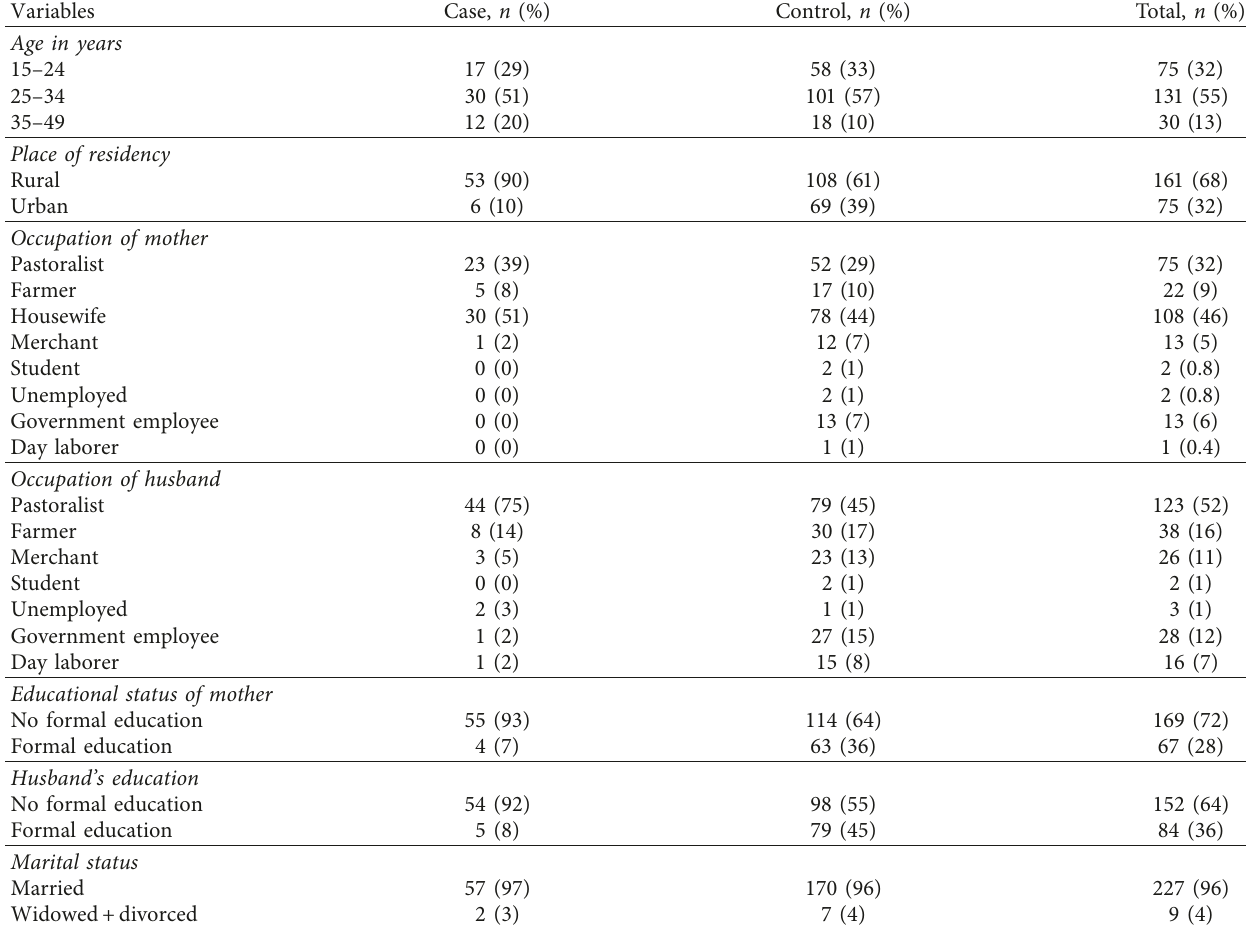
Table 2: Sociodemographic characteristics of pregnant women who delivered between September 2014 and March 2017 at pastoralist area of Borena zone, Oromia region, Ethiopia ( n �